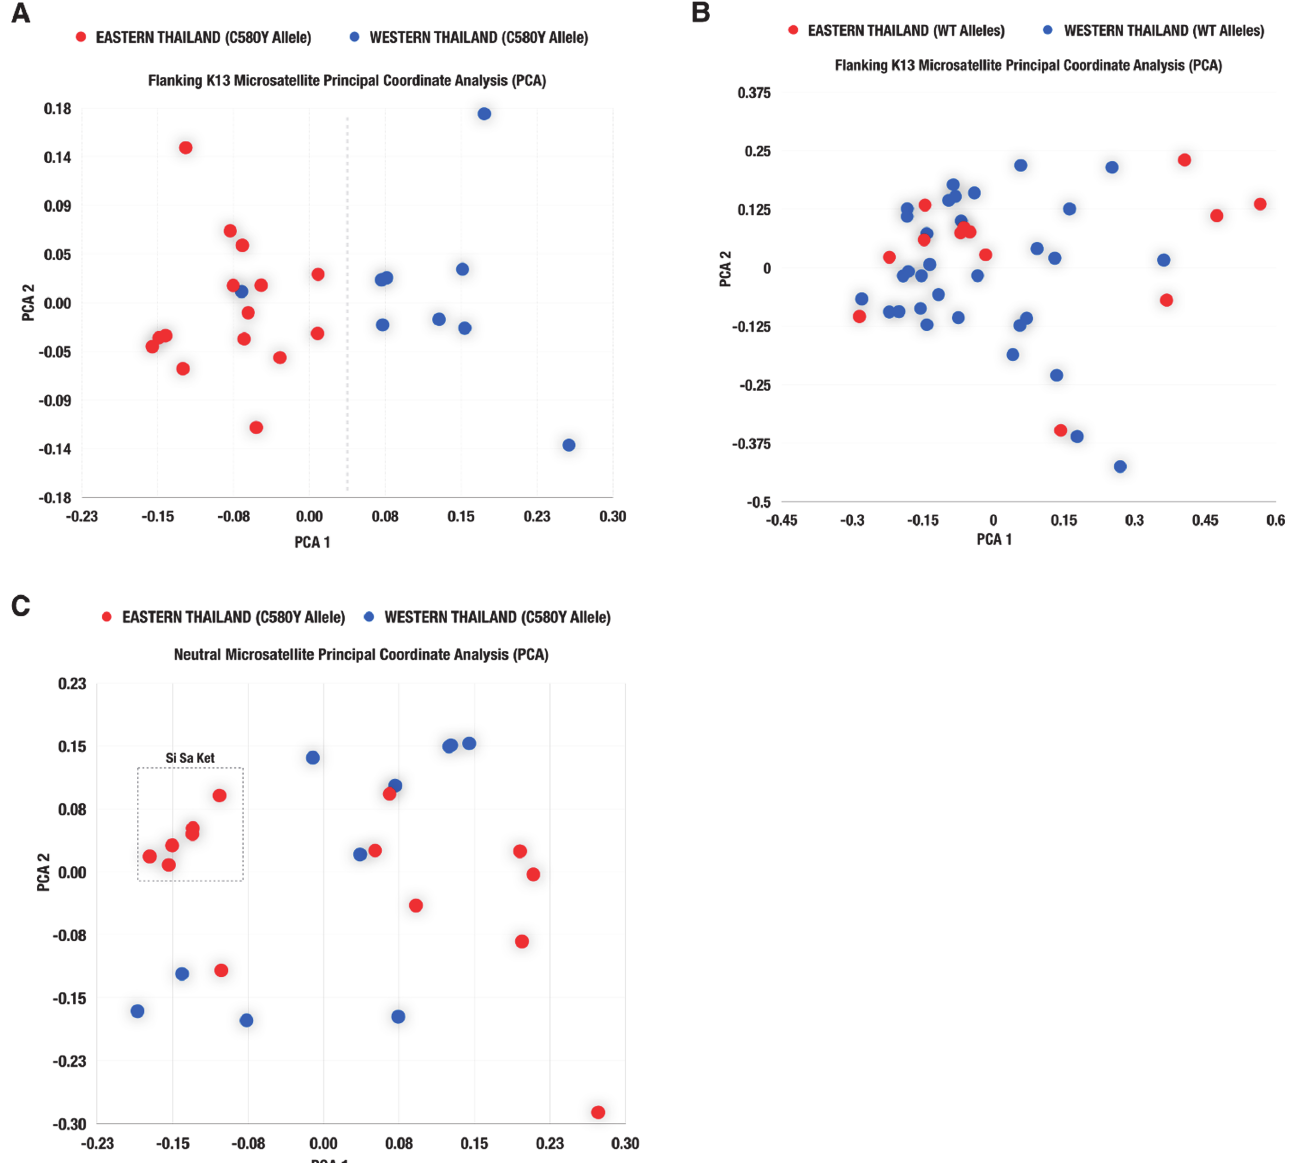
Fig 4. Population structure by geography. Scatter plots from principal component analysis (PCA) based on flanking K13 microsatellite analysis of parasite isolates with the C580Y allele (A) and wild type allele (B). Results of PCA based on neutral microsatellites for parasite isolates carrying the C580Y allele, are shown in